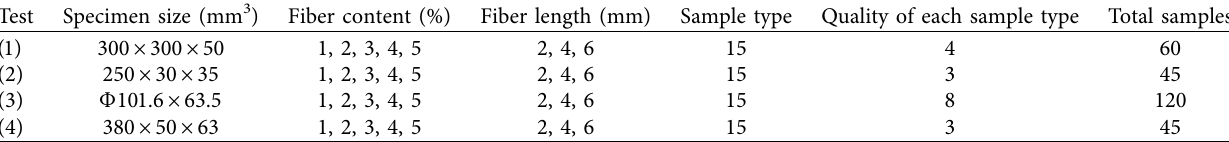
Table 5: Basic performance test